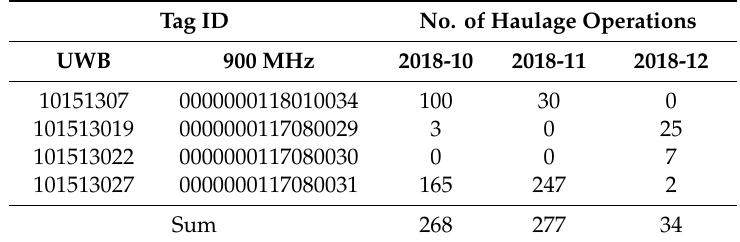
Table 4. Tag ID information attached to 4 trucks and the number of haulage operations during 3 months.